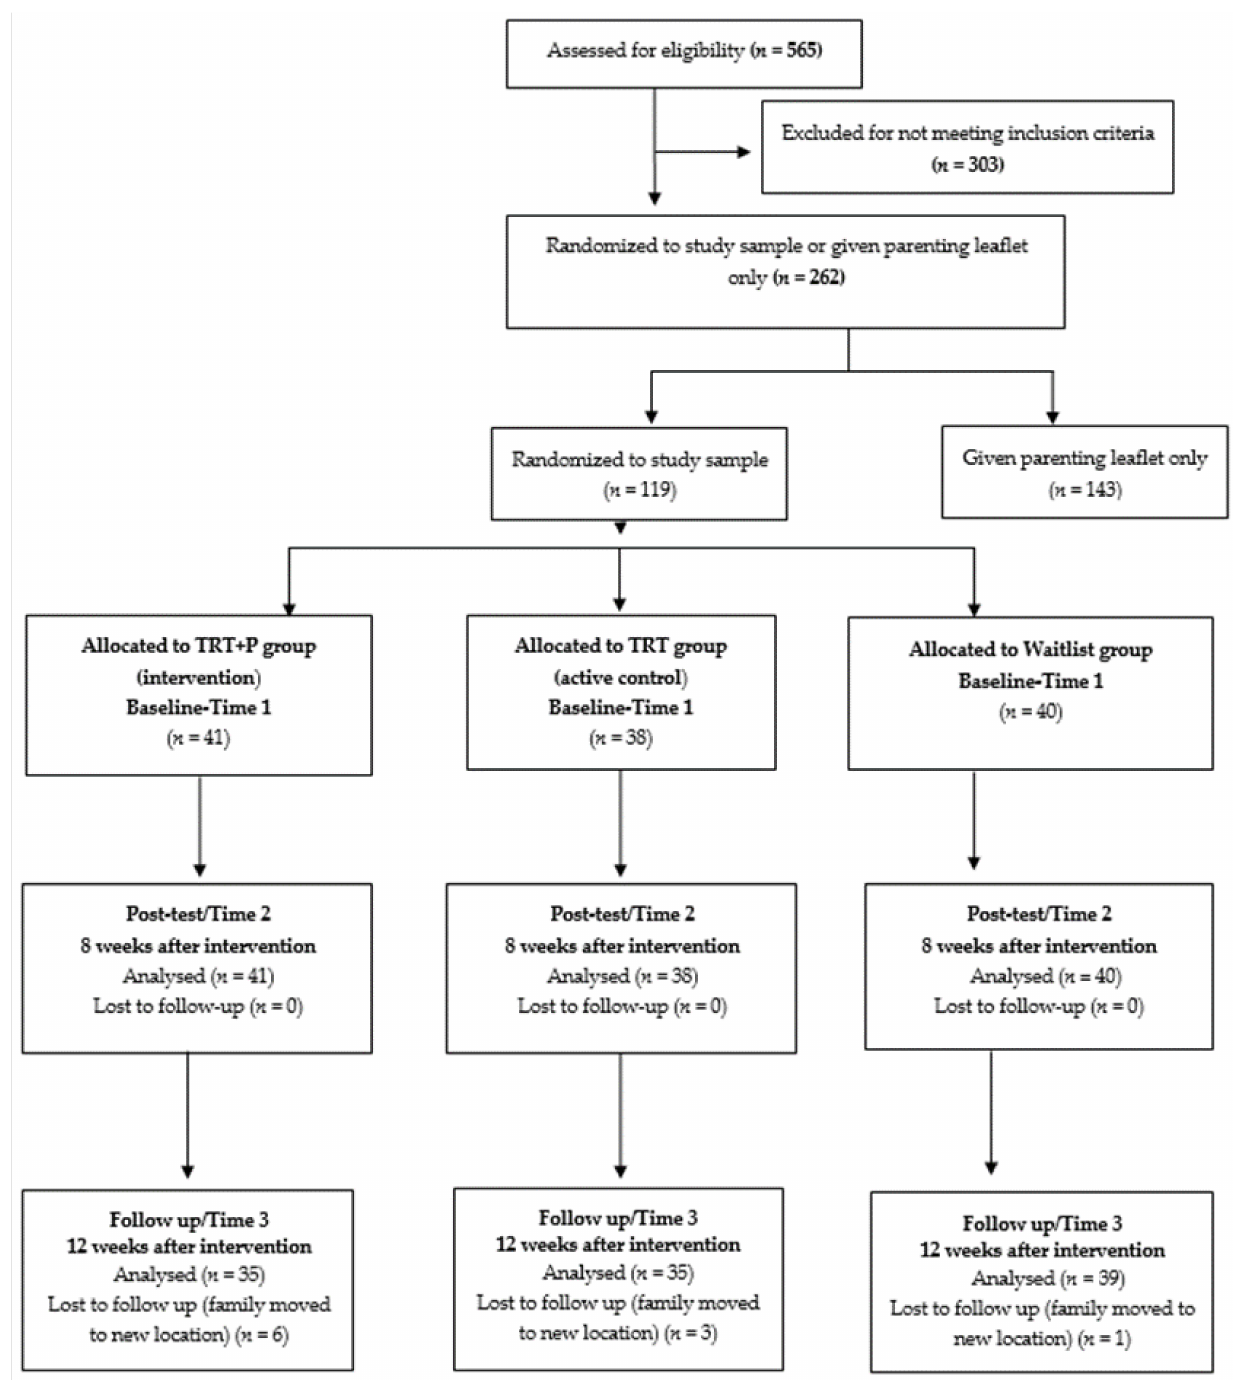
Figure 1. Consort diagram; recruitment of participants, follow-up and missing data over